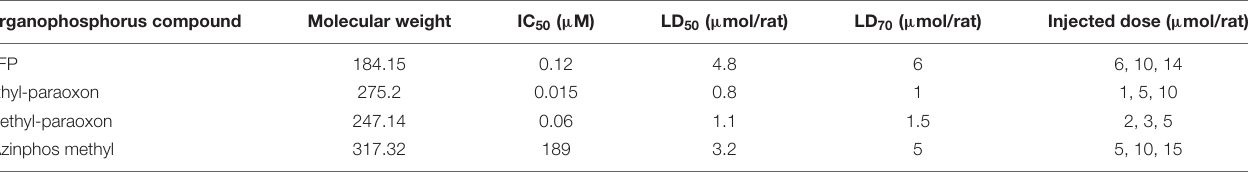
TABLE 3 | Chemical and biological parameters of the investigated OPCs. Organophosphorus compound Molecular